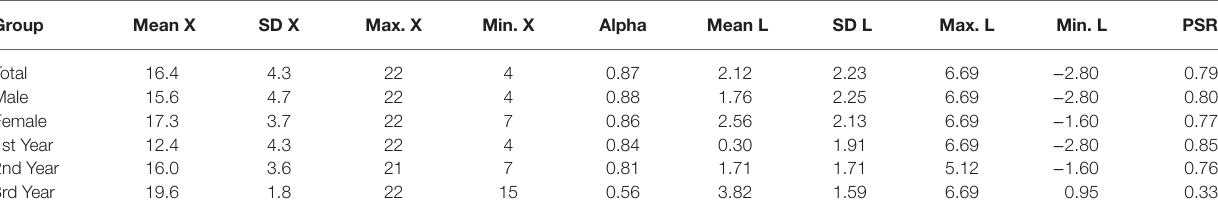
TABLE 3 | Language. Descriptive statistics of the participants’ scores.